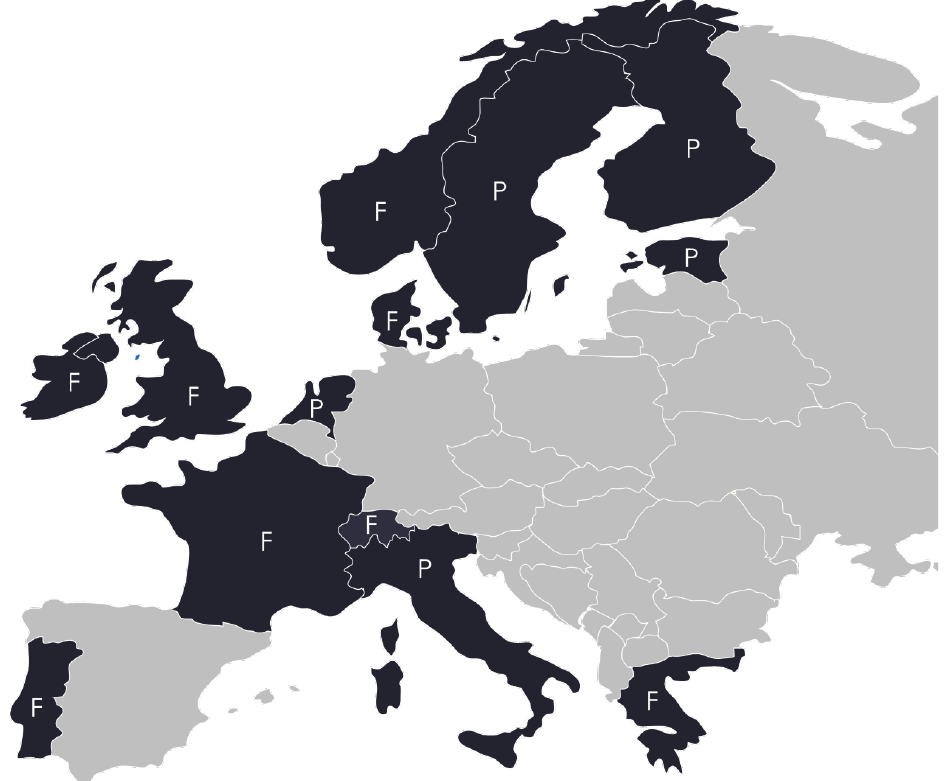
Figure 1. European countries with flu vaccinations available in pharmacies. F—the possibility of